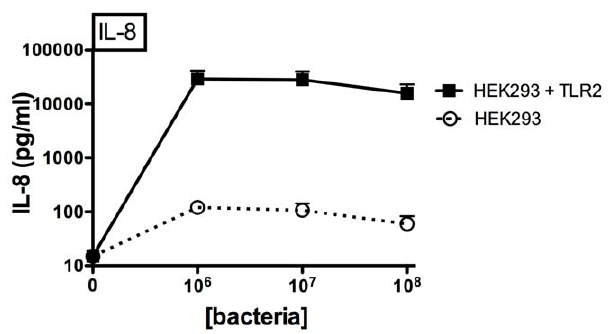
Figure 1. Transfection of human embryonic kidney cells with TLR2 confers responsiveness to live SE. Transfection of HEK293 cells with TLR2 enhanced SE-induced IL-8 production after 24 h of stimulation (n=3).